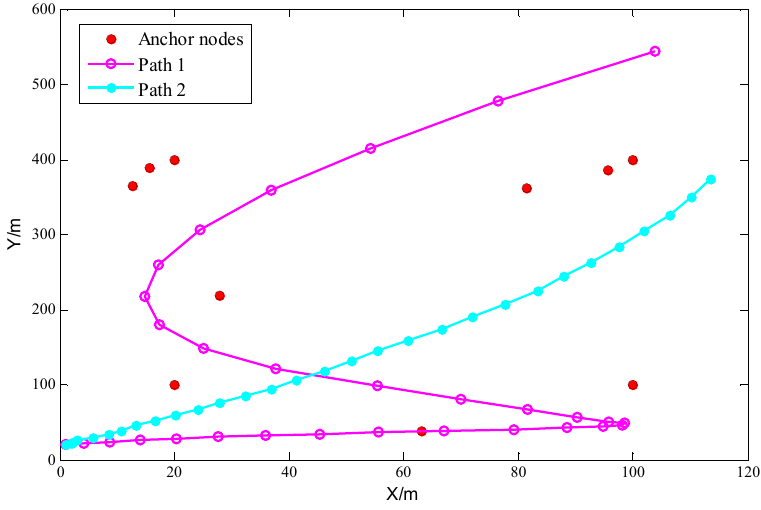
Figure 5. Simulation scenario.